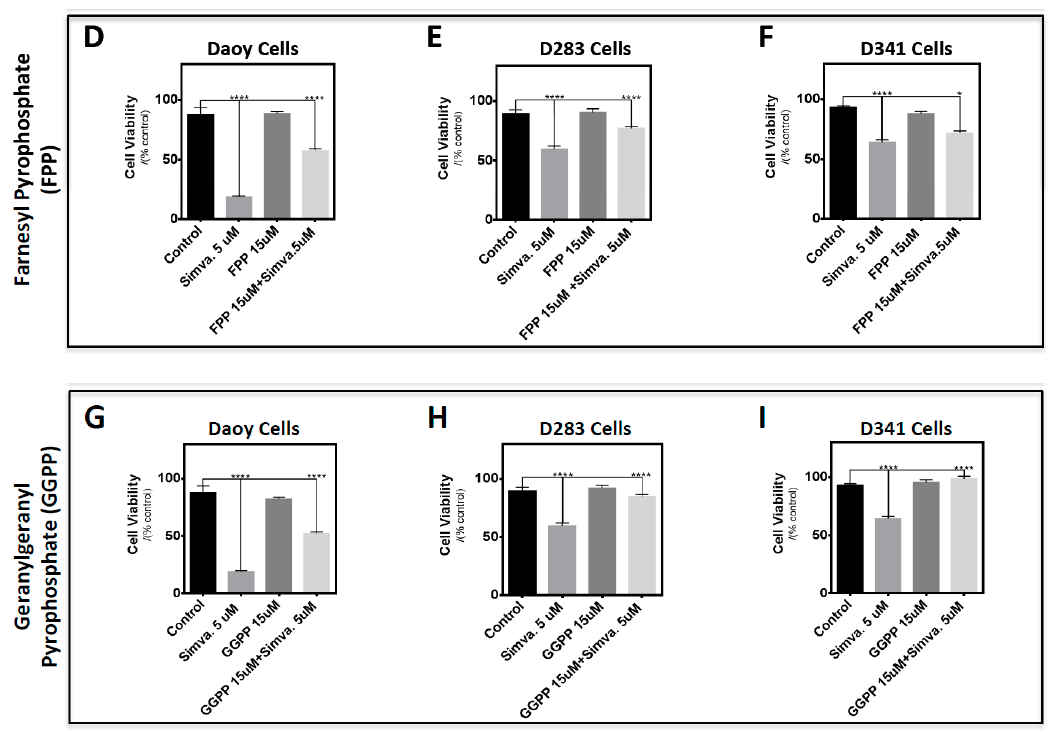
Figure 5. Mevalonate and isoprenoid intermediates rescue simvastatin-induced cell death via mevalonate cascade inhibition. Daoy ( A , D , G ), D283 ( B , E , H ), and D341 ( C , F , I ) cells were pre-treated with 5 mM mevalonate ( A – C ), 15 µM farnesyl pyrophosphate (FPP) ( D – F ), and 15 µM gernaylgerany parophosphate (GGPP) ( G – I ), followed by 5 µM simvastatin treatment. Cells were incubated for 96 h and cell viability was measured by the 3-(4,5-Dimethylthiazol-2-yl)-2,5-diphenyltetrazolium bromide (MTT) assay. Results show that MeV, FPP, and GGPP significantly reduce medulloblastoma cell death. Statistical significance was reported by one-way ANOVA using GraphPad Prism 7.0. p -value is reported as **** p < 0.0001 or * p < 0.05. Data are expressed as means ± SEM, and n = 15. A comparison of the results obtained from the three cell lines (Figure 6) showed that GGPP 100% reversed simvastatin-induced cell death in both D283 and D341 cells, while in Doay cells, GGPP could not rescue 100% of simvastatin-induced cell death. In addition, FPP and GGPP rescue is significantly higher in D283 and D341 cells compared to Doay cells (Figure 6A–D) ( p < 0.0001, and p < 0.001).